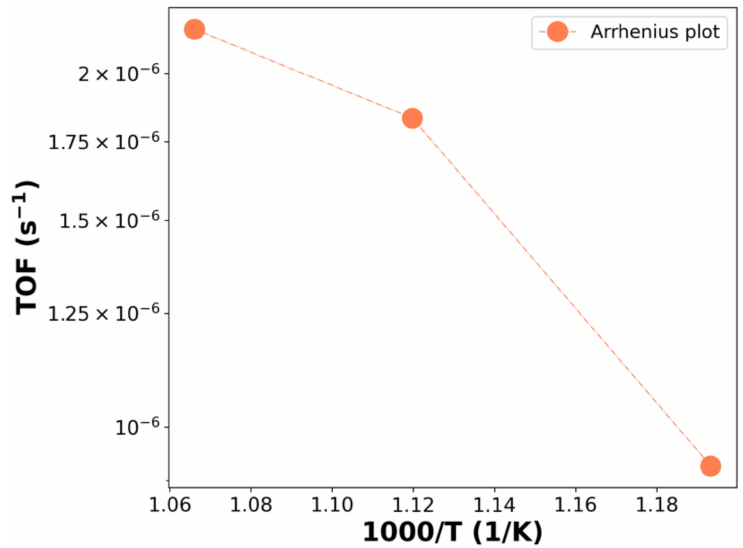
Figure 8. Arrhenius plot for naphthalene decomposition over Fe/CAG-ps. Temperature values: 565 ◦ C, 620 ◦ C, and 665 ◦ C.